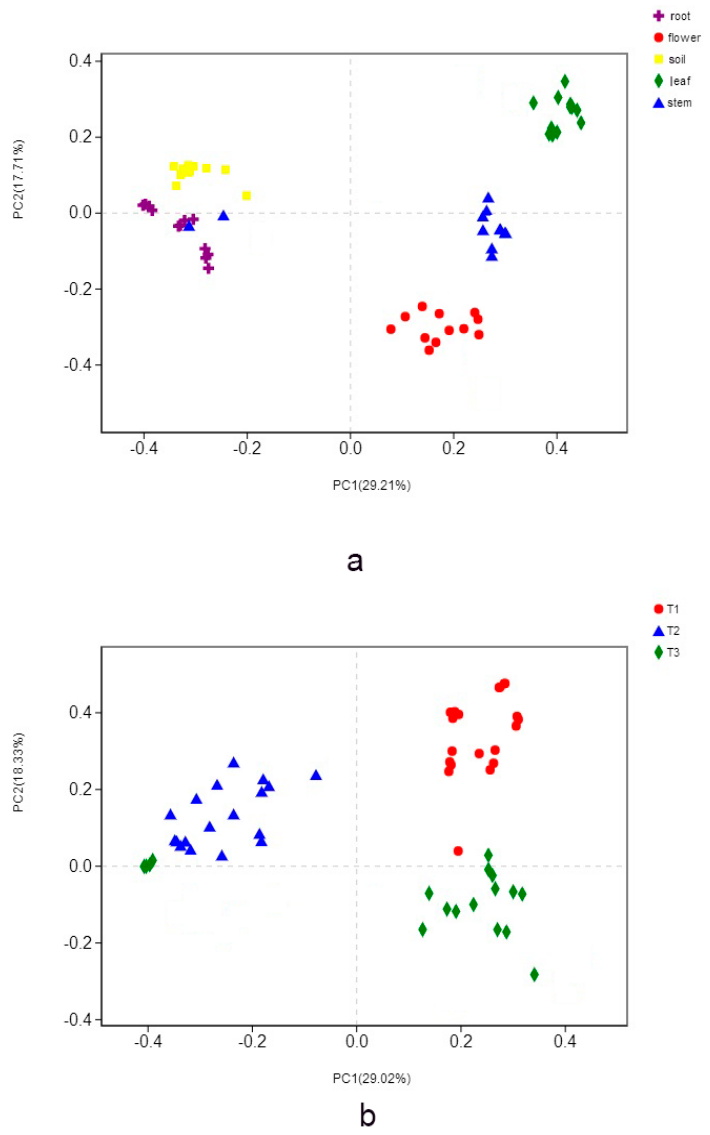
Figure 5. Principal coordinates analysis (PCoA) based on the relative abundance of fungal OTUs showing the fungal community structure: ( a ) in different organs and soil of the Pinggu peach trees; ( b ) in three different cultivars.